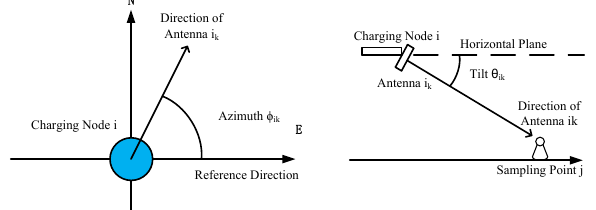
Figure 2. The relationship between antenna angle parameters and sampling point position.